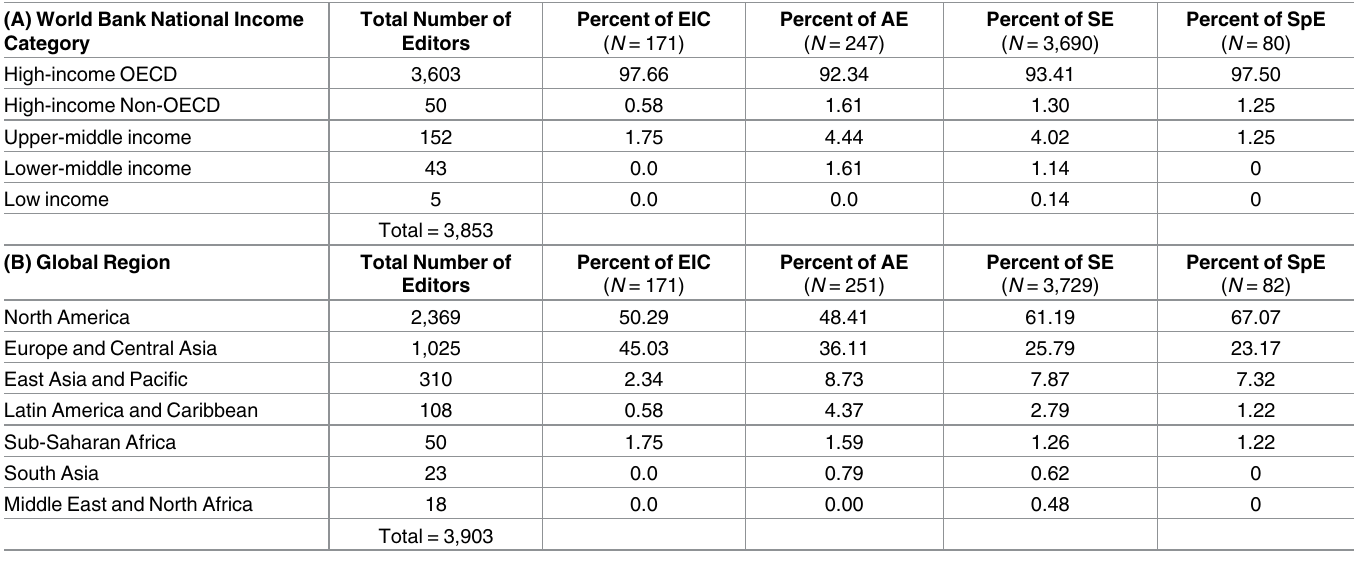
Table 1. Percentage of the editorial board members from 24 environmental biology journals based in different (A) World Bank country income cat- egories and (B) global regions. Between 1985and 2014, there were 3,827 uniqueeditors from 70 countries. The total numberof editors in each region and nationalincome category differs due to some editors having moved between1984 and 2015; similarly, 1 person may serve